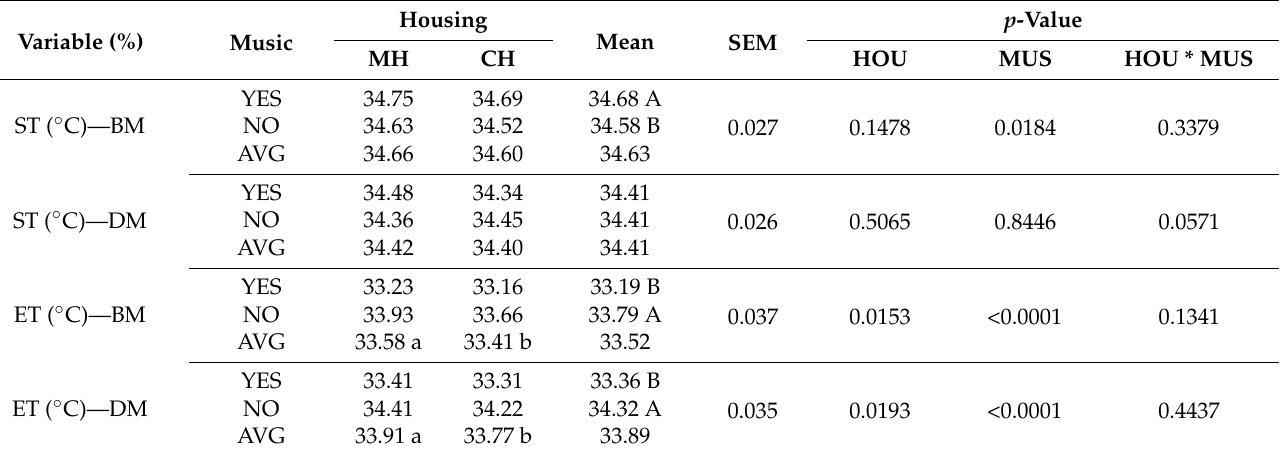
Table 2. Mean body surface temperature and eye temperature of pregnant sows in mixed housing or collective housing before and during exposure to auditory environmental